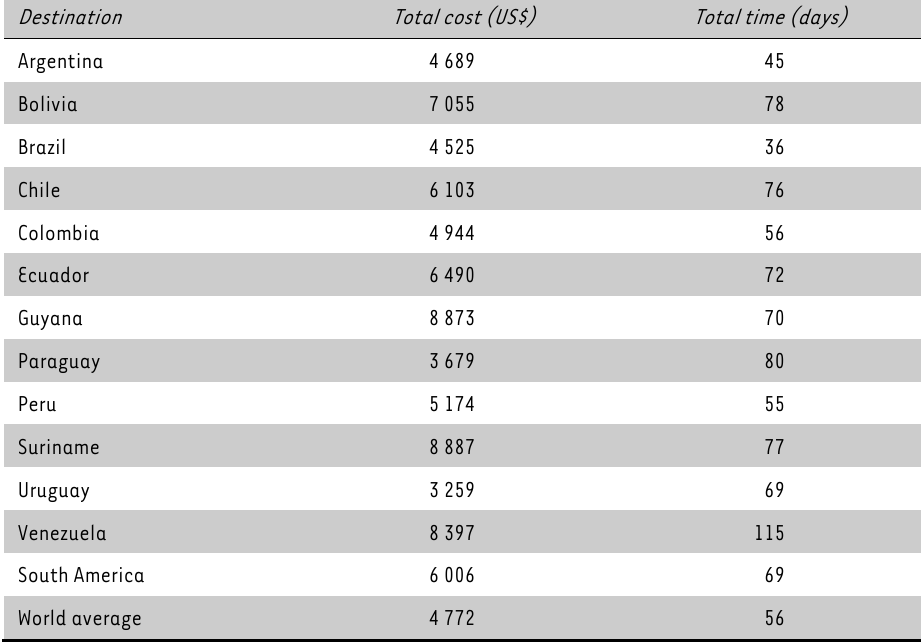
TABLE 4: Total cost and time to export goods from South Africa to the different countries in South America